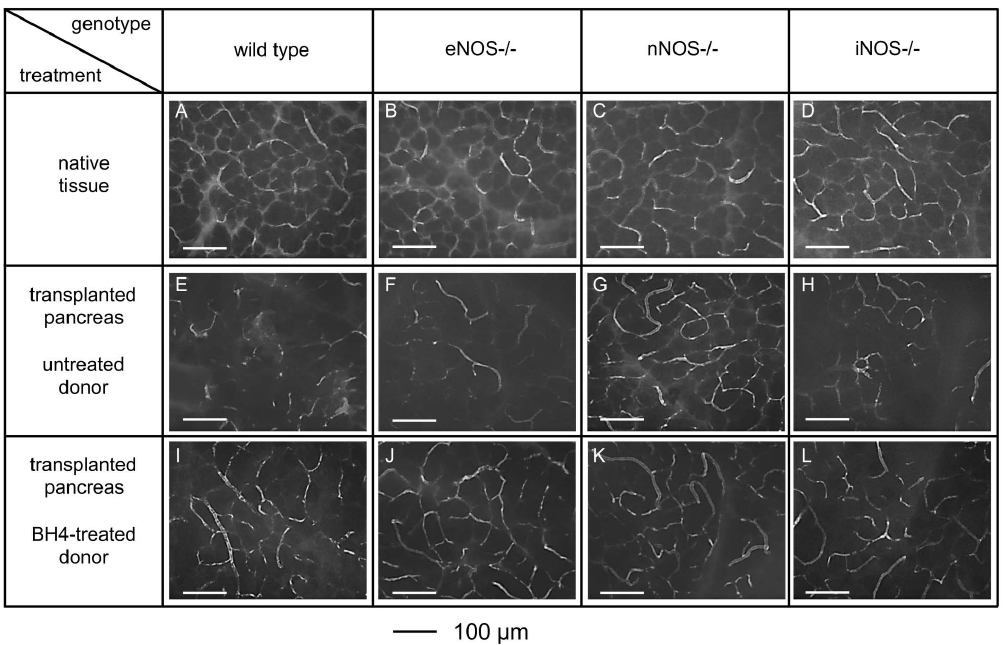
Figure 1. Capillary mesh of pancreata in dependence of donor treatment and donor genotype. Pancreata were taken from BH4-treated or untreated donors with the indicated genotypes, subjected to ischemia, and transplanted to wt recipients of the same background as the knockouts (n=5 per group). The capillary mesh was stained by infusion with fluorescein labelled dextran and observed by CIVFM. A–D: non- transplanted organs of wt, eNOS 2 / 2 , nNOS 2 / 2 and iNOS 2 / 2 . E–H: organs of untreated donors (wt, eNOS 2 / 2 , nNOS 2 / 2 and iNOS 2 / 2 , respectively), transplanted to wt recipients, 4 h after reperfusion. I–L: organs of donors treated with BH4 (wt, eNOS 2 / 2 , nNOS 2 / 2 and iNOS 2 / 2 , respectively), transplanted to wt recipients, 4 h after reperfusion.